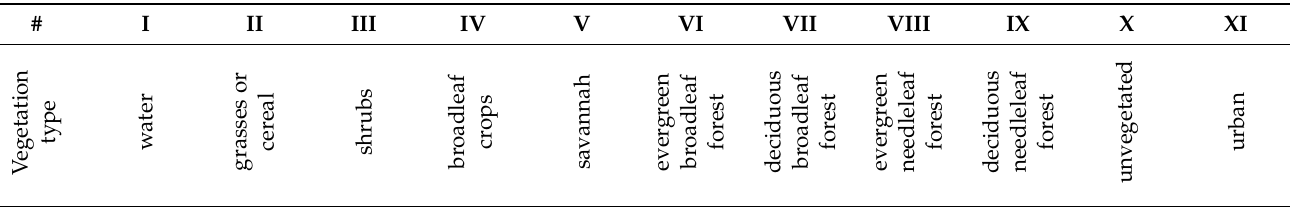
Table 2. Vegetation types (land cover) [64] and their associated numbering (roman numbers) that are used in this